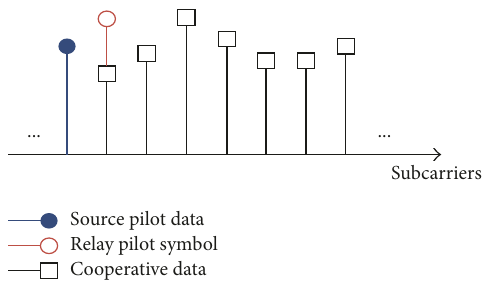
Figure 2: Structure of a frame with superimposed pilots in fre- quency